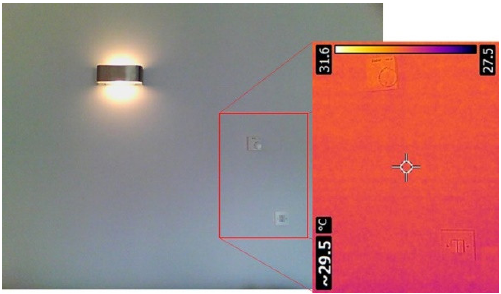
Figure 7. The partition wall and thermogram of the area where the hidden junction box is located.